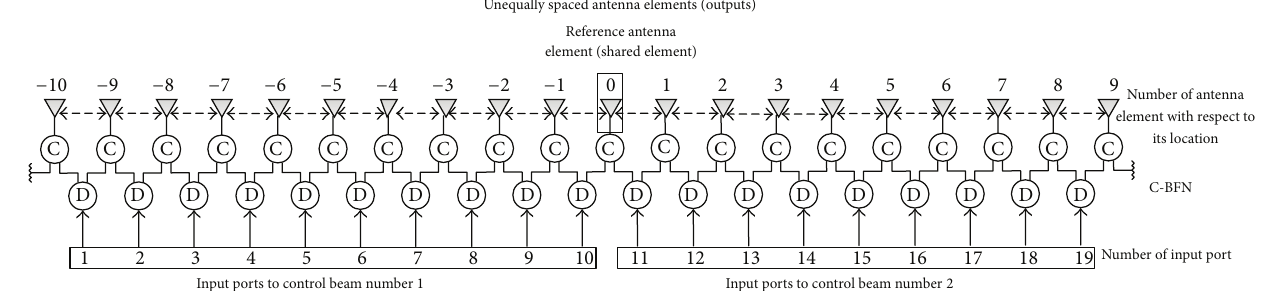
Figure 2: Schematic of the two-beam configuration showing the C-BFN and its interconnection with the nonuniformly spaced linear array.